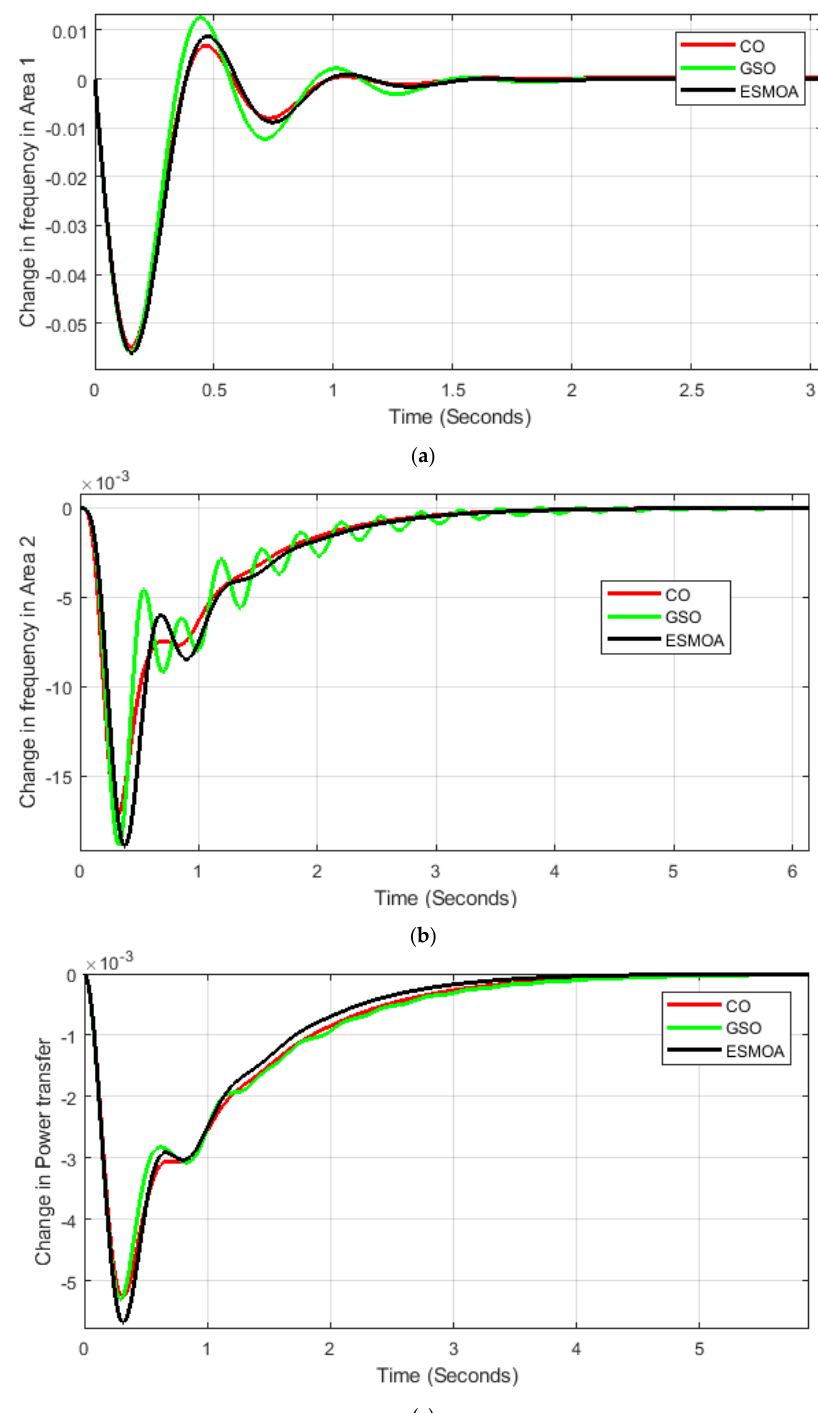
Figure 6. Dynamic responses for CO, GSO, and the proposed ESMOA for Case 1. ( a ) Deviation in frequency in area 1. ( b ) Deviation in frequency in area 2. ( c ) Deviation in transferred power through interconnected